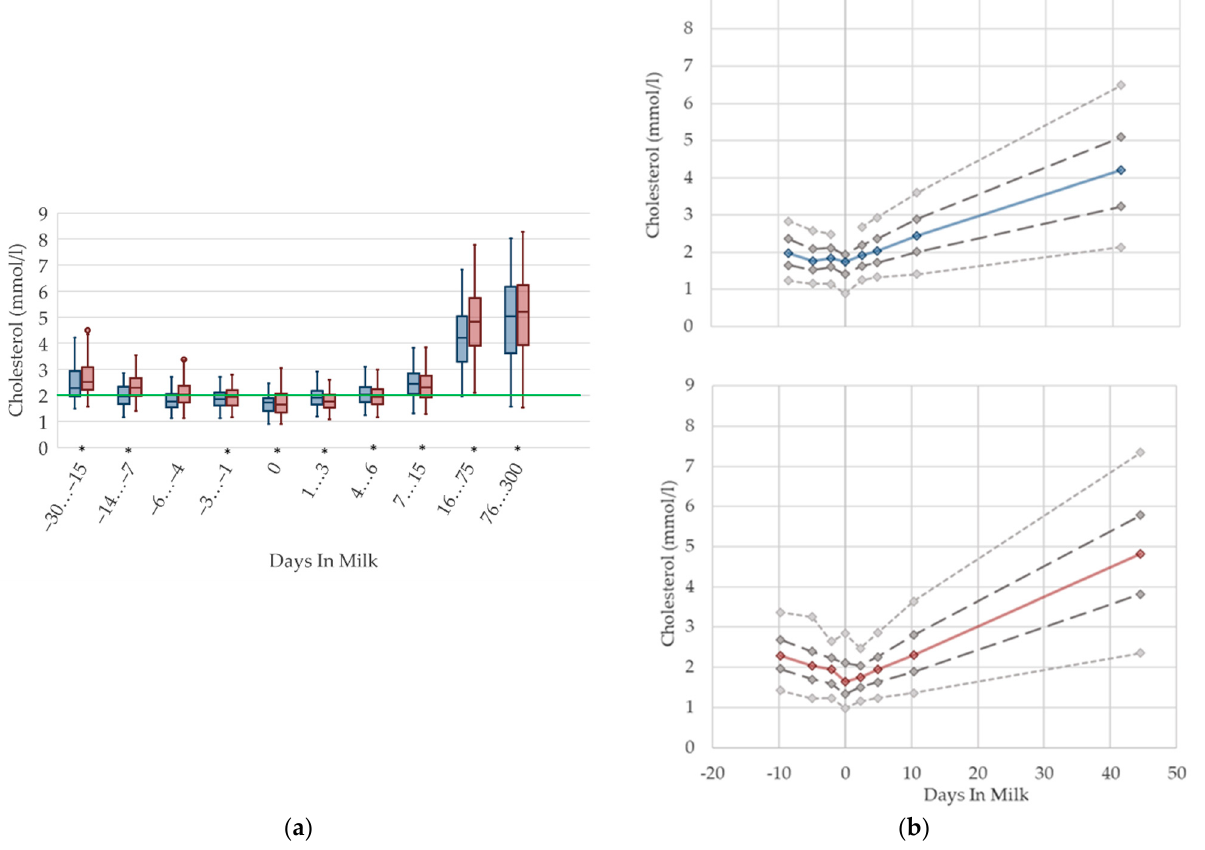
Figure 4. Serum concentrations of cholesterol in primiparous (blue) and in multiparous (red) cows ( a ) in 10 classes between 30 days prepartum to 300 days postpartum (boxplots), green continuous lines represent the reference values according to Fürll [23], asterisk indicates significant differences regarding parity within DIM class; and ( b ) in 8 classes from 10 days prepartum to 40 days postpartum (median—continuous line; 1st and 3rd quartile—dashed lines; percentile 5 and 95—dotted lines).